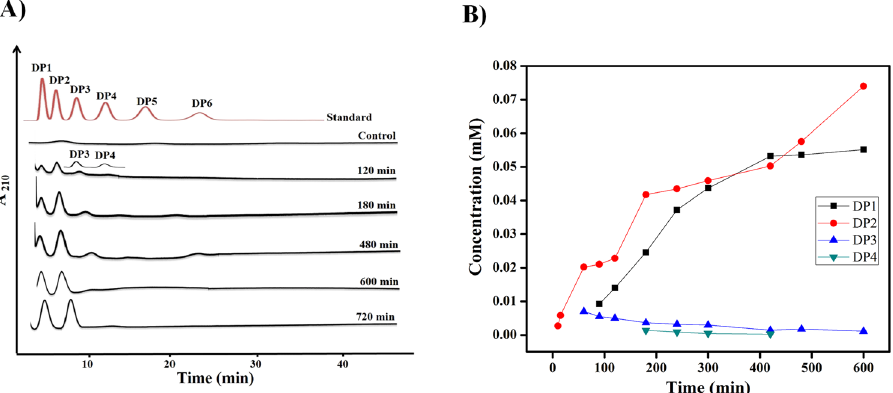
Figure 3. Hydrolysis of colloidal chitin by Ec Chi1. The Ec Chi1 (0.8 μ M) was incubated with 30 mg/ml of the substrate in 900 μ L reaction mixture for different time periods from 0 to 720 min at 40 °C. The reaction products were analyzed by binary gradient HPLC. ( A ) The topmost profile shows a standard mixture of CHOS ranging from DP1 to DP6. The remaining profiles are the reactions at different incubation times. Control represents the substrate without Ec Chi1 while standard represents CHOS ranging from DP1 to DP6. ( B ) Overview of the quantifiable CHOS products generated during hydrolysis. Products were quantified from respective peak areas using standard calibration curves of CHOS ranging from DP1 to DP4.